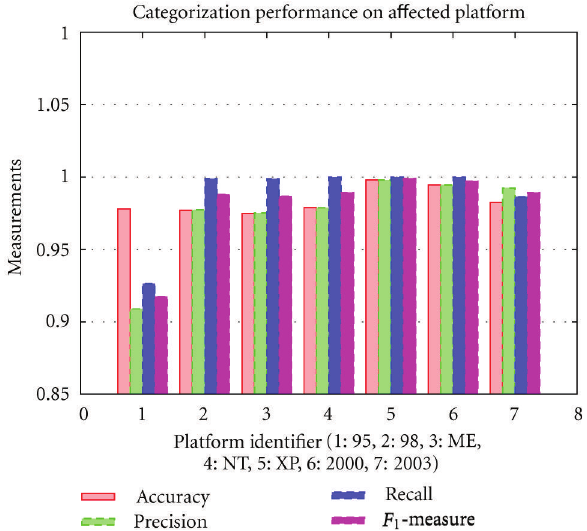
Figure 2: Classification accuracy, precision, recall, and F 1 -measure for A ff ected Platform.